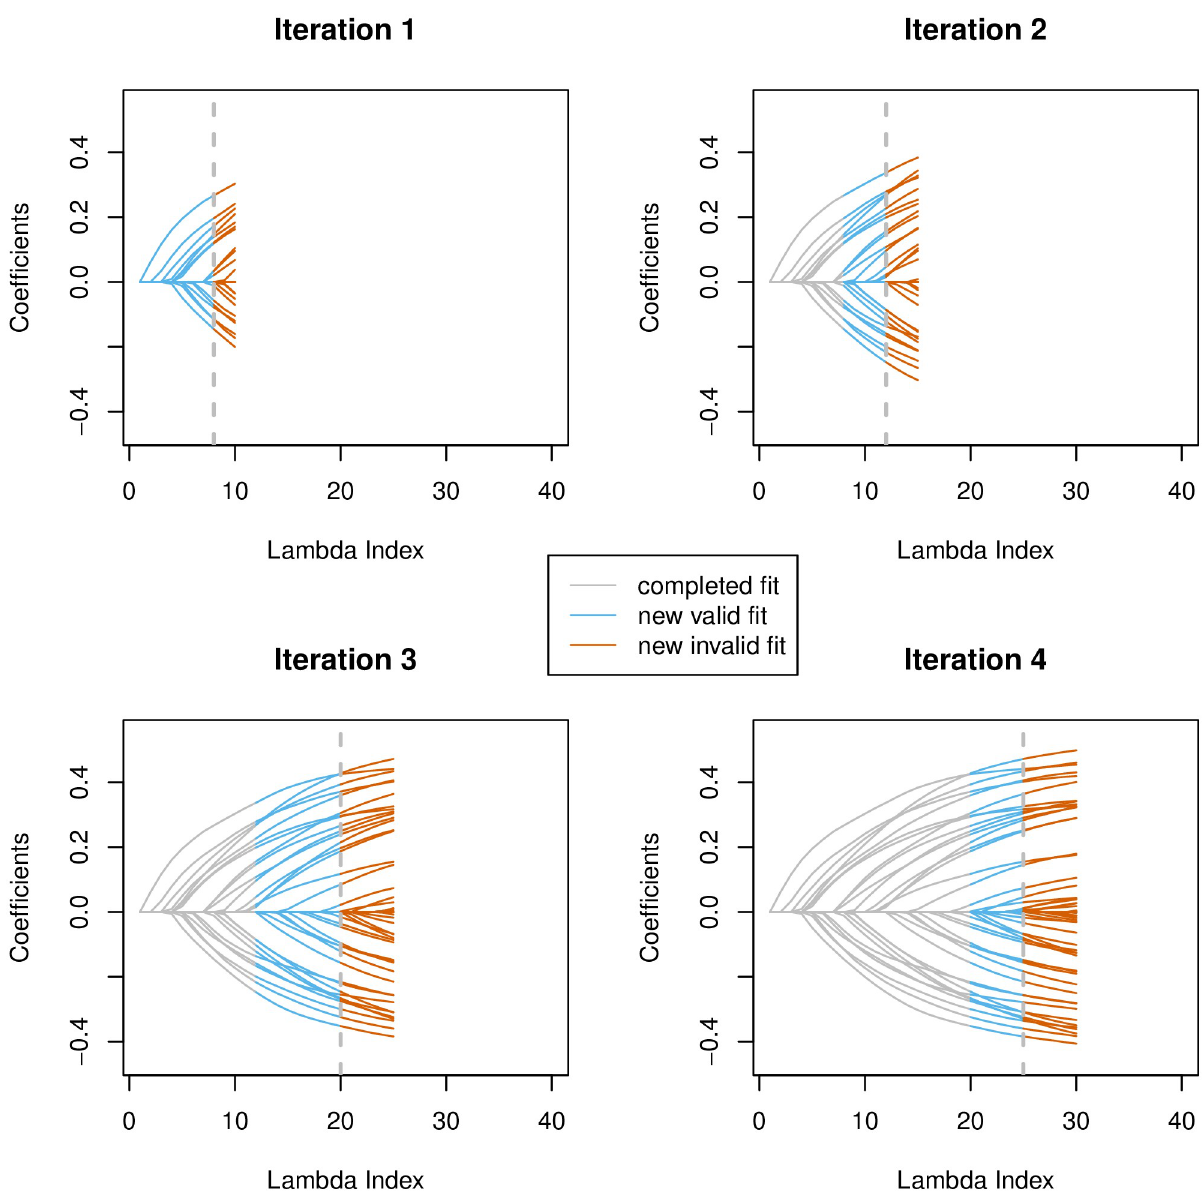
Fig 1. The lasso coefficient profile that shows the progression of the BASIL algorithm. The horizontal axis represents the index of lambda values, 1 � ℓ � L , which correspond to the sequence of the regularization parameters, λ 1 > λ 2 > ��� > λ L . The previously finished part of the path is colored grey, the newly completed and verified is in sky blue, and the part that is newly computed but failed the verification is colored orange. The largest lambda index with the verified model is highlighted with vertical dotted gray line.